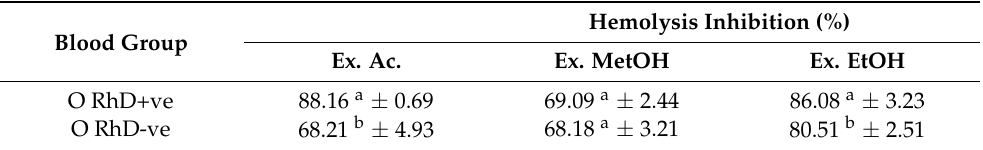
Table 6. Antihemolytic activity of N. incerta extracts against the oxidative hemolysis induced by AAPH on erythrocytes O RhD+ve and RhD-ve.